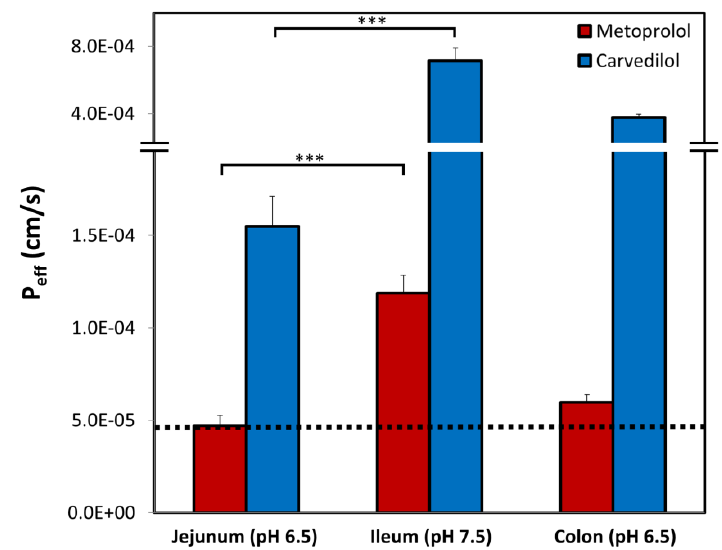
Figure 5. Effective permeability coefficient (P eff ; cm/s) obtained for carvedilol vs. metoprolol in three rat intestinal segments, the upper jejunum (pH 6.5), terminal ileum (pH 7.5), and the colon (pH 6.5). The black dashed line represents the permeability of metoprolol in the jejunum (pH 6.5), which is the low/high P eff class boundary standard. Data are presented as means ± SD; *** p < 0.001 between jejunum and ileum for both carvedilol and metoprolol; n = 6.